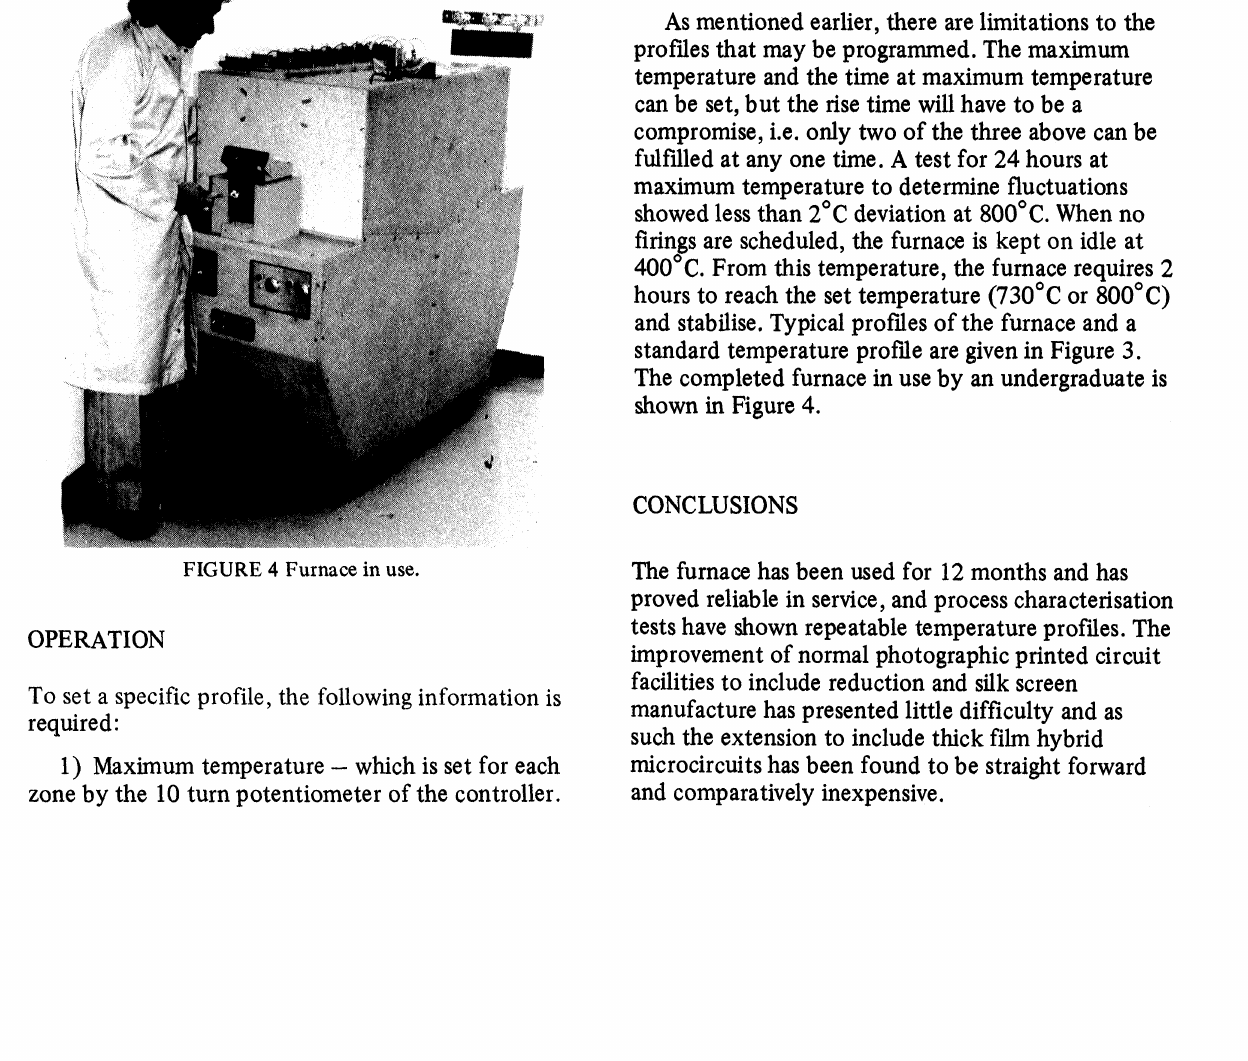
FIGURE 3 Temperature